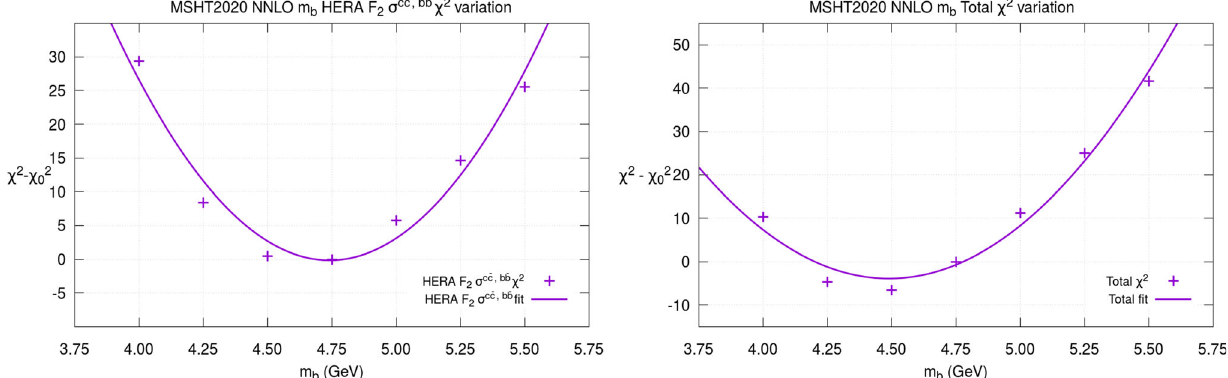
) = 0 . 118 for (left) the reduced cross section for heavy flavour Z